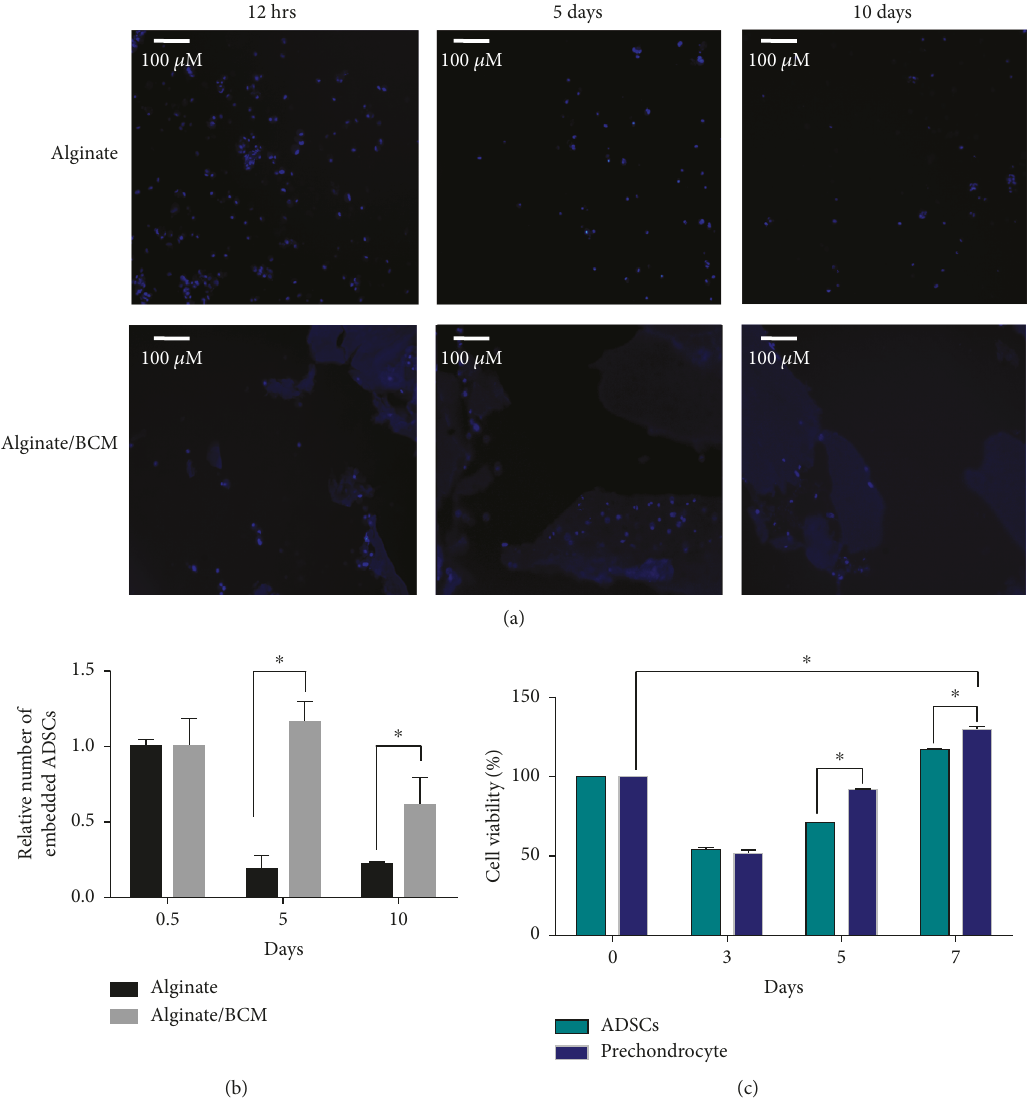
Figure 3: Cellular distribution and viability onto the alginate/bovine cartilage matrix tridimensional sca ff old. (a) ADSCs retained in the sca ff olds after 12 h and 5 and 10 days of cellularization, evaluated by fl uorescence microscopy according to the number of nucleus stained with DAPI. (b) Quantitative image analysis: the data represent the average of 15 fi elds taken as 1.0, the number of cells at 12h. (c) Alamar Blue cell viability assay of ADSCs and prechondrocytes in the biofunctionalized alginate sca ff old at 0, 3, 5, and 7 days of culture ( ∗ p < 0 05